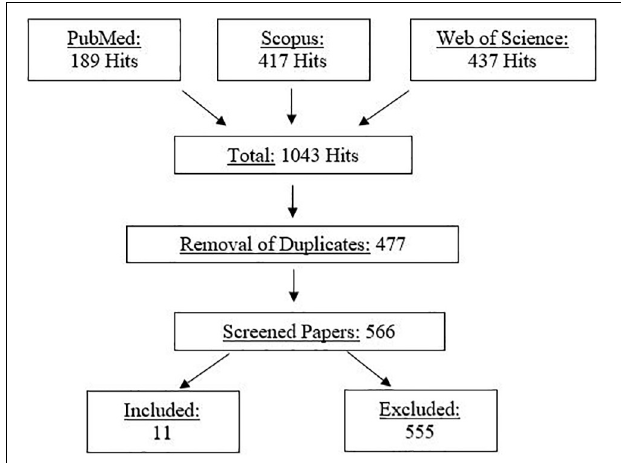
FIGURE 1 | Flowchart of the systematic screening process